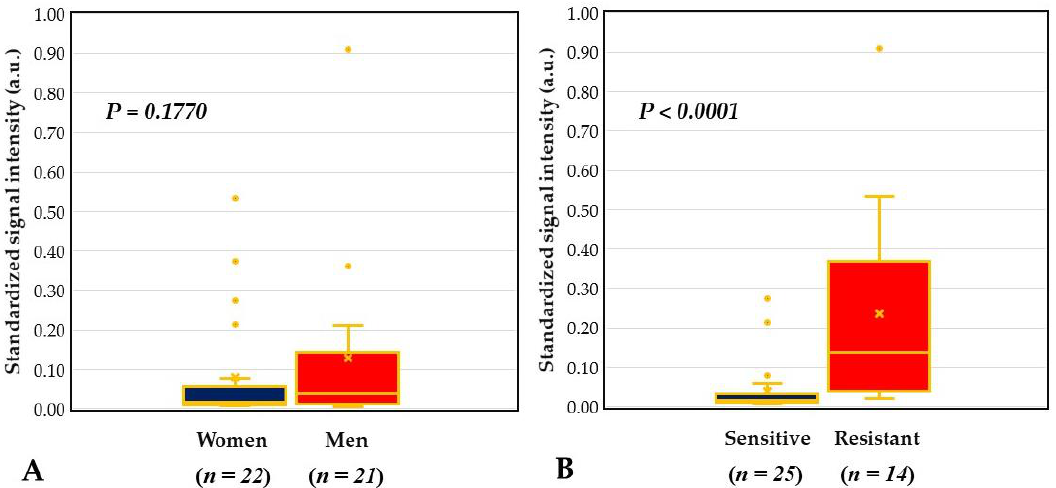
Figure 8. Comparison of antibiotics resistance surveilling probe mecA signal between di ff erent groups. ( A ) No significant sex di ff erence in the signal intensity of mecA. ( B ) Patients with oxacillin-resistant strains (resistant group) had higher signal intensity of mecA than those without oxacillin-resistant strains (sensitive group). a.u. = arbitrary unit.